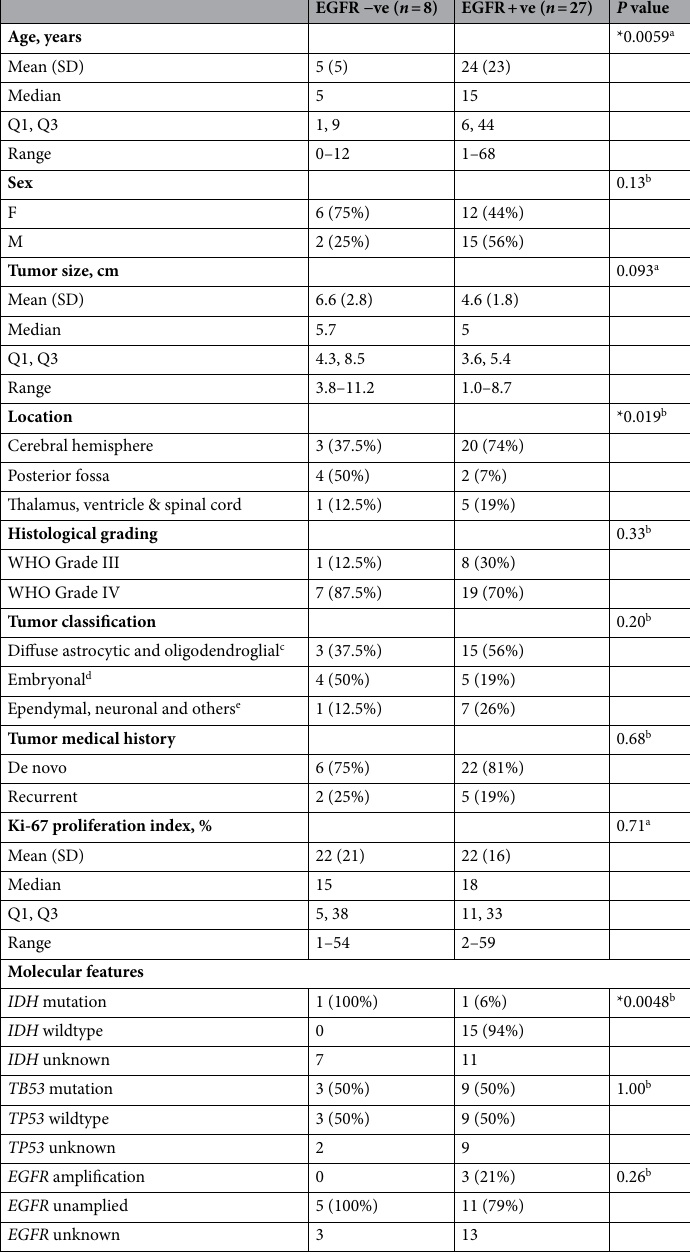
Table 1. Patient demographics. a Wilcoxon rank-sum test. b Pearson’s chi-squared test. c